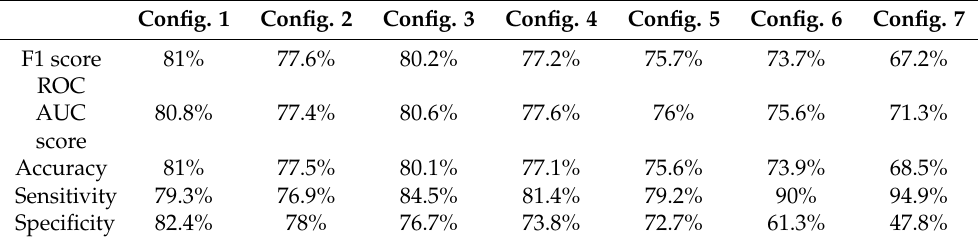
Figure 24. Accuracy and loss for Configuration 2, overlapping dataset.